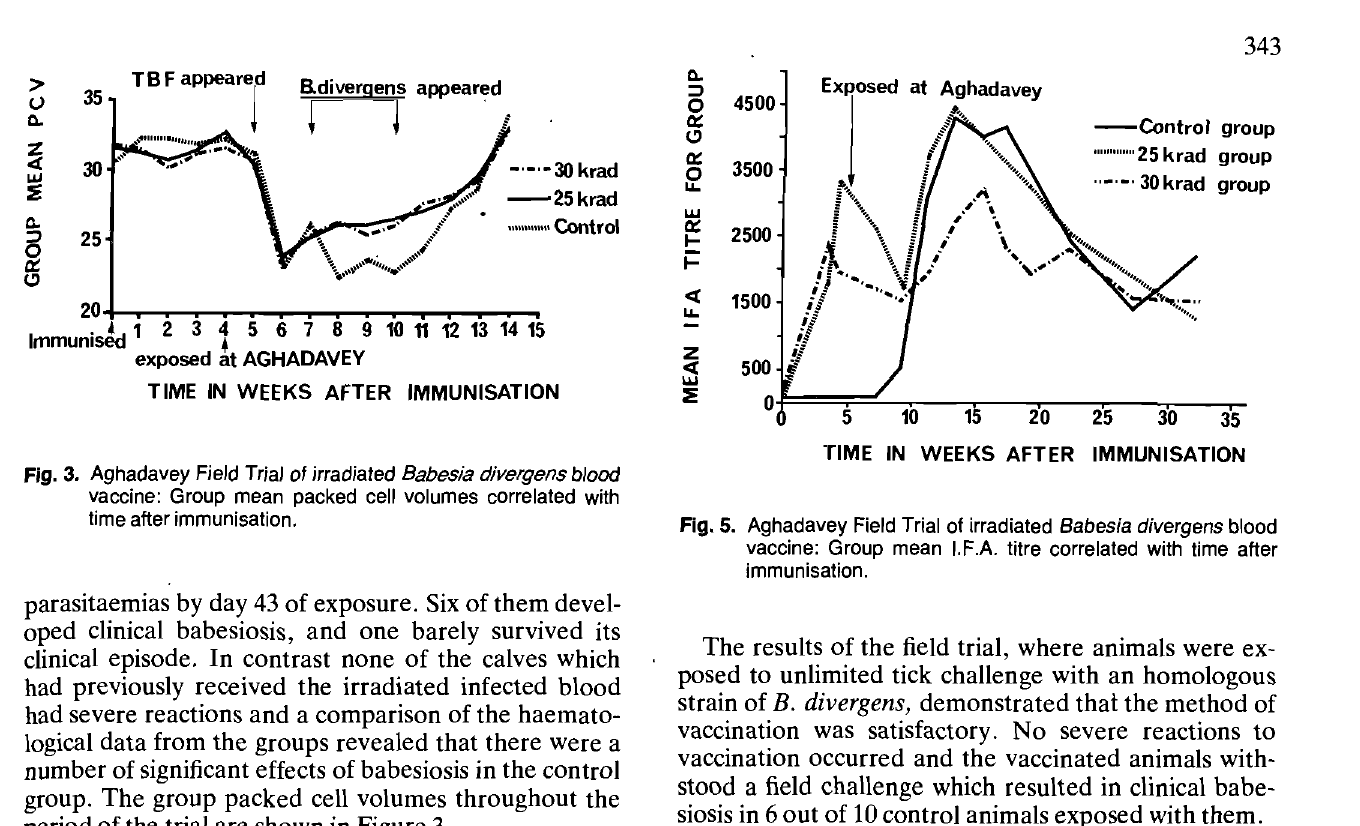
Fig. 3. Aghadavey Field Trial of irradiated Babesia divergens blood vaccine: Group mean packed cell volumes correlated with time after immunisation.